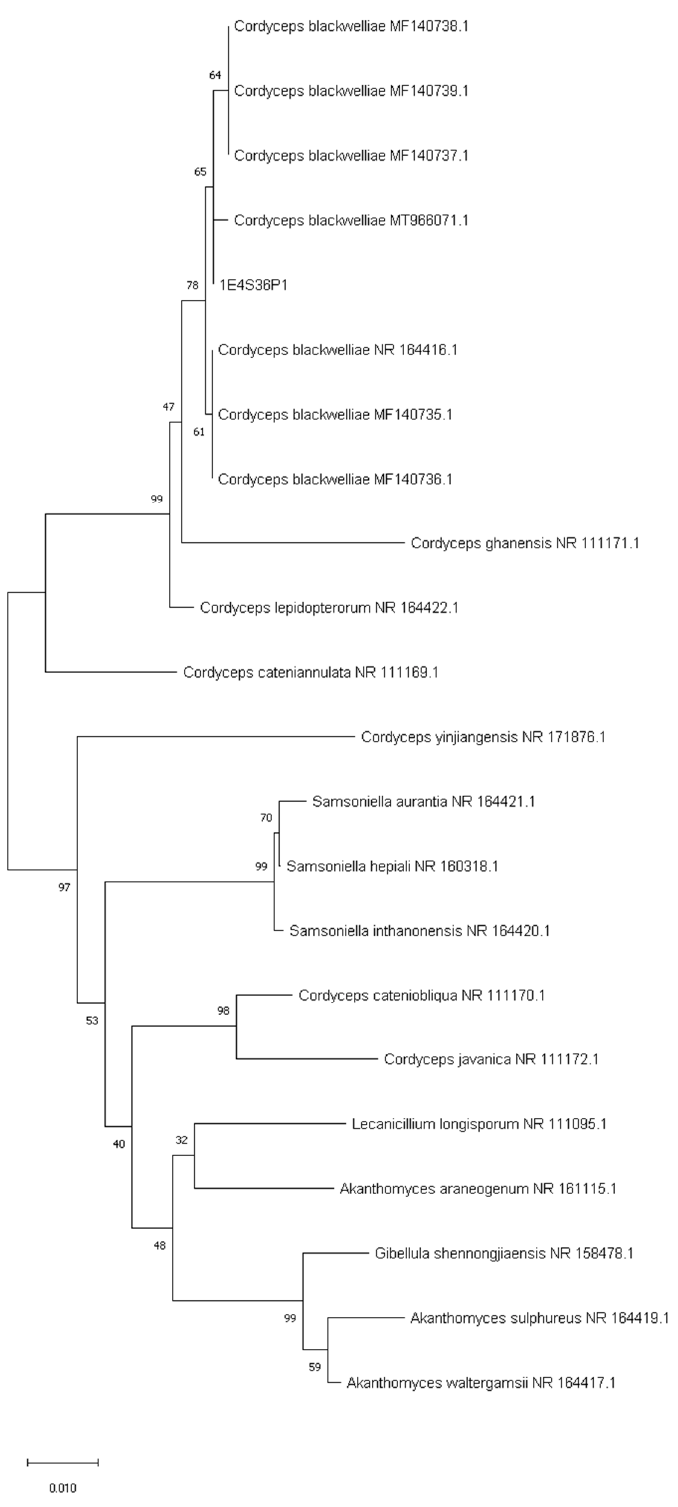
Figure 5. Phylogenetic tree of C. blackwelliae with the new isolate from Greece (1E4S36P1 RID: 8E2M17WB01R) and related species from GenBank. The species names are followed by the GenBank accession numbers.